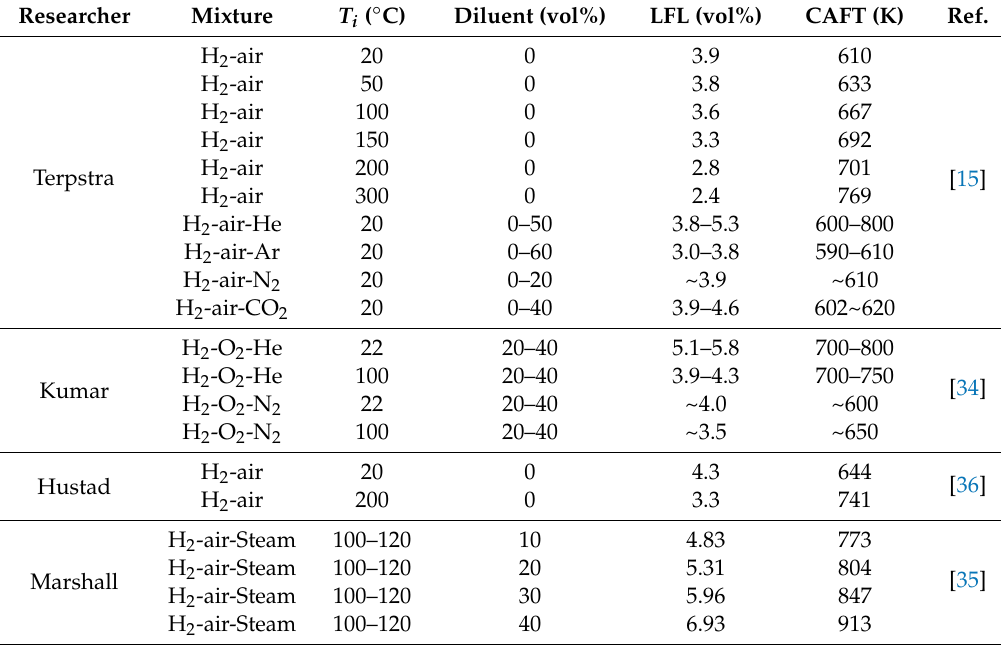
Table 10. The CAFT for various limiting mixtures, Reproduced from Ref. [11], Korean Nuclear Socity: